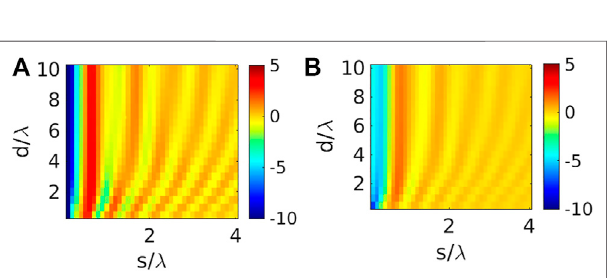
FIGURE 3 | Variation of Δ P (in dB) for the con fi guration in Figure 1 with respect to d / λ and s / λ considering 4 × 4 array of loops as the IRS, with: (A) r (cid:1) 0.1 λ , (B) r (cid:1) 0.2 λ . Here p (cid:1) 2 r +2